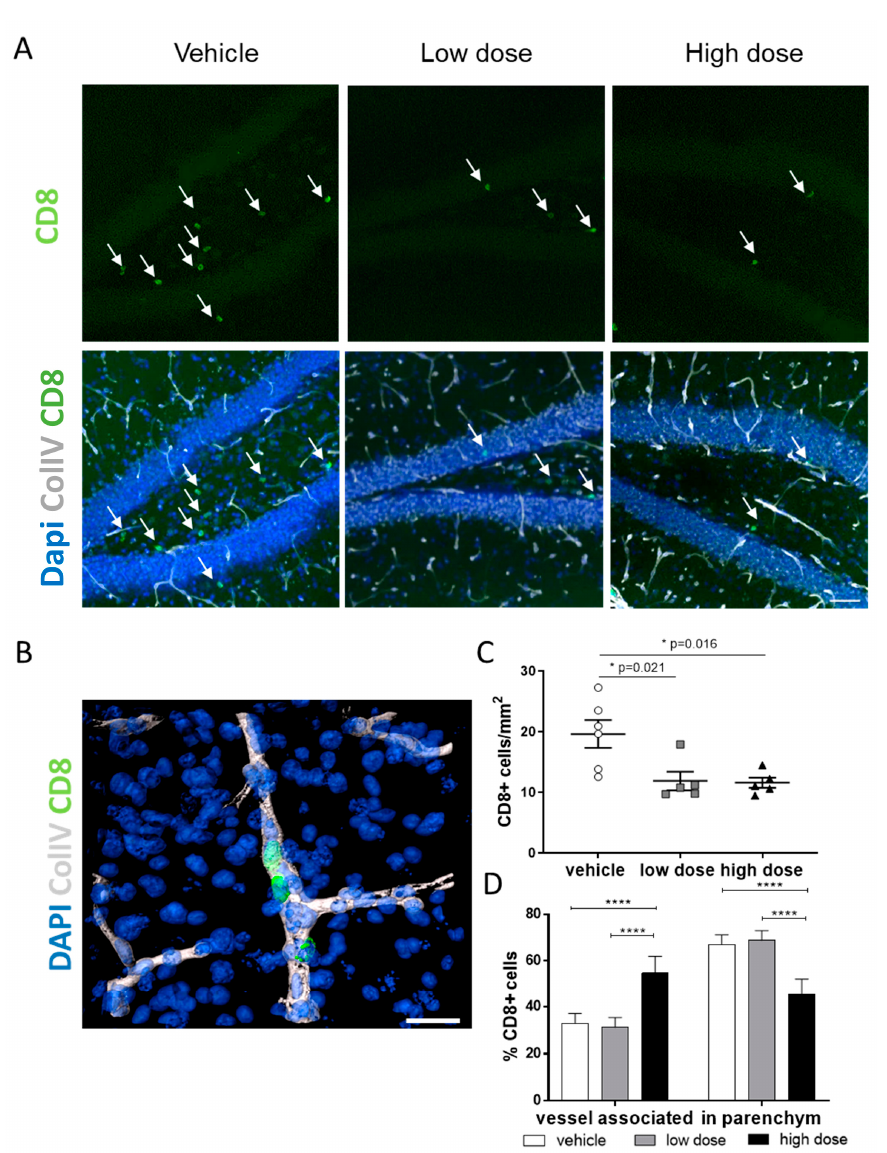
Figure 5. Immunohistochemical analysis of CD8+ T-cells in the hippocampus. ( A ) Representative images of parenchymal CD8+ T-cells and ColIV in the hippocampus. Scale bar: 10 µm ( B ) Repre- sentative image of vessel-associated CD8+ T-cells. Scale bar: 5 µm ( C ) Number of CD8+ T-cells per mm2 with and without MTK. ( D ) Distribution of CD8+ T-cells between vessel and parenchyma among all groups. Data are shown as mean +/- SEM. One-way ANOVA was performed with Tukey´s post hoc test. P -values of p < 0.0001 and p < 0.001 were considered extremely significant (**** or ***), p < 0.01 very significant (**) and p < 0.05 significant (*). Images were created with Zen blue ( A ) and Imaris ( B ).